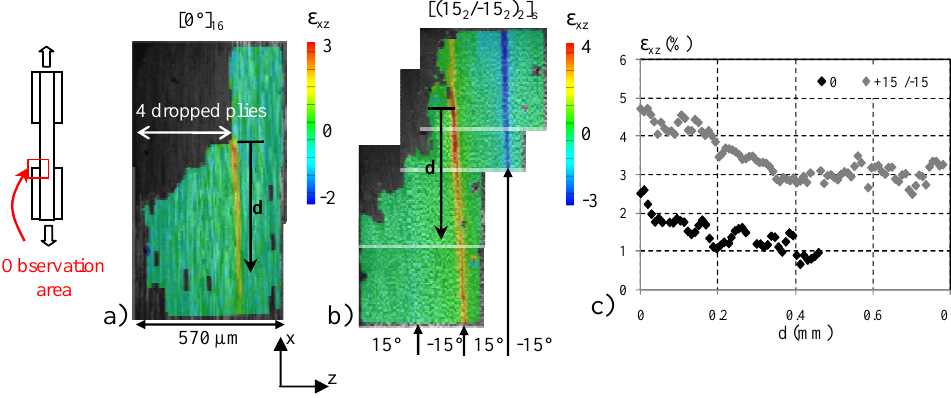
Fig. 11. e xz shear strain field in the vicinity of a ply drop with (L,D)=(60,40) and 1pixel = 0.21µm on [0]16 (a), and on [(15 2 /-15 2 ) 2 ] s (b) pure-UD-HM free edge. c) Variation of e xz as function of the distance d to the ply